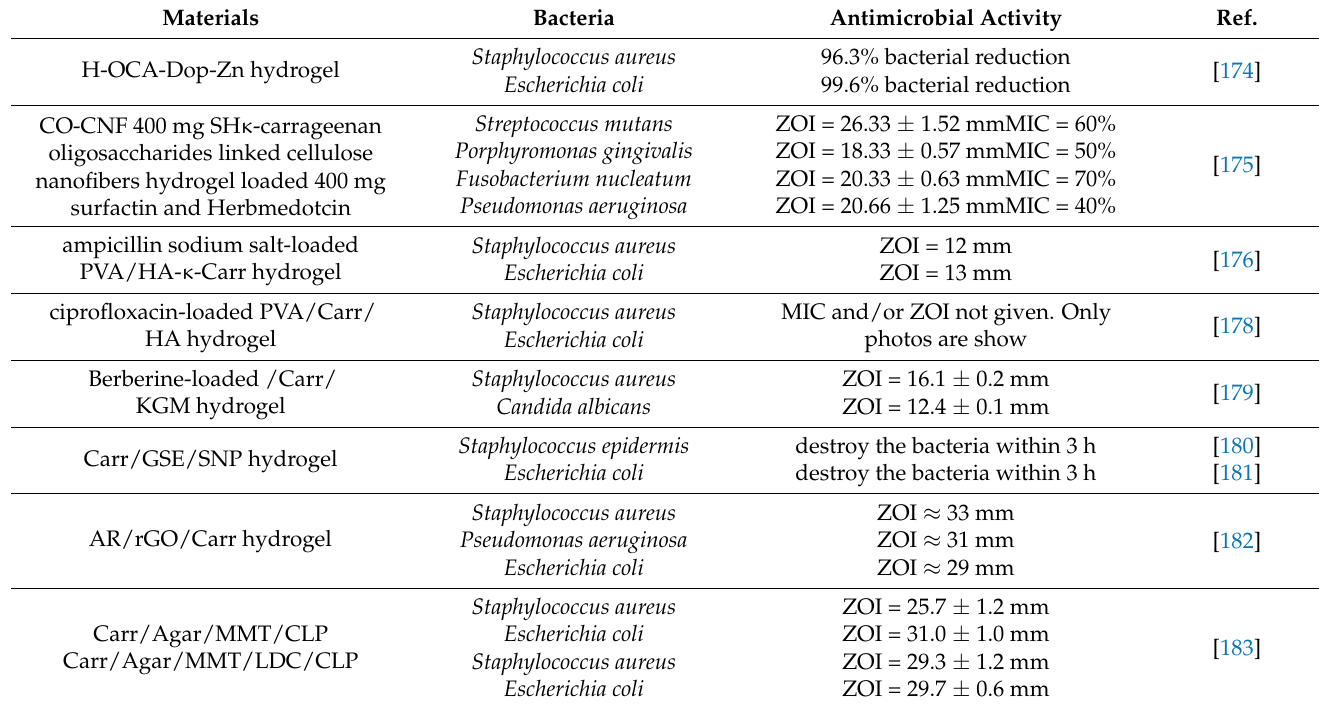
DI—diameter of inhibition zone, MIC—minimum inhibitory concentration, ZOI—zone of inhibition.